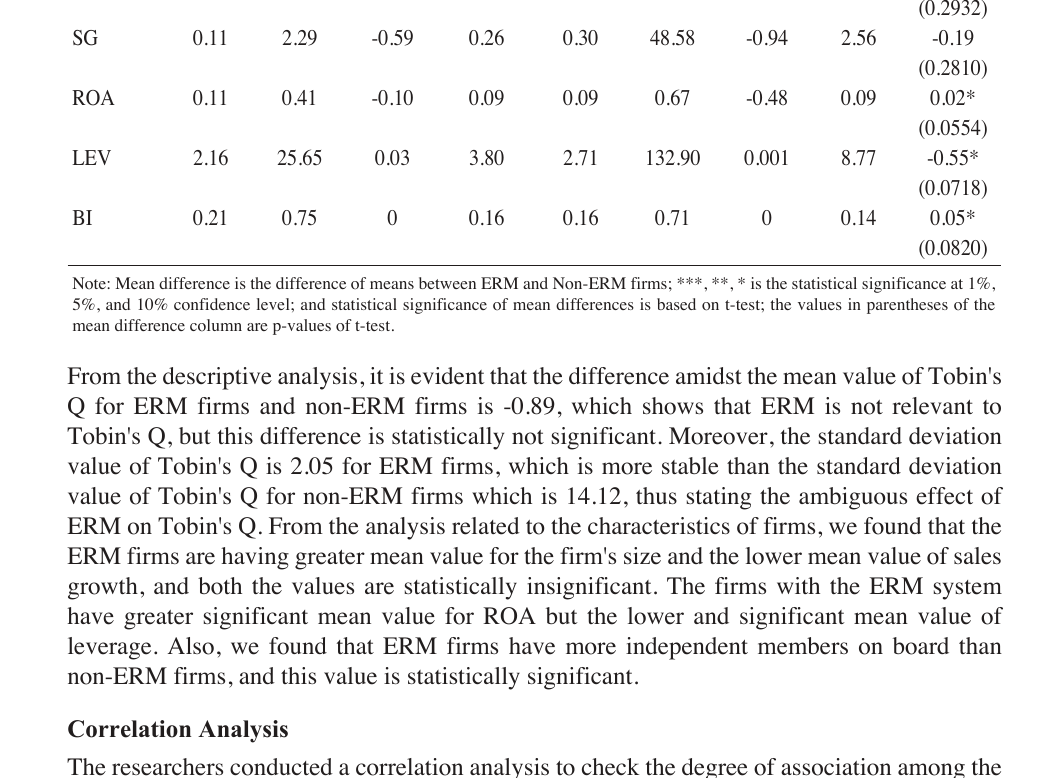
Table 1: Descriptive Statistics of Variables for ERM and Non-ERM Firms for the period of 2009-17 ERM Firms (22 firms) Non-ERM Firms (43 firms) Variables Mean Max Min Std. Dev. Mean Max Min Std. Dev. Mean TOBIN’S Q 1.87